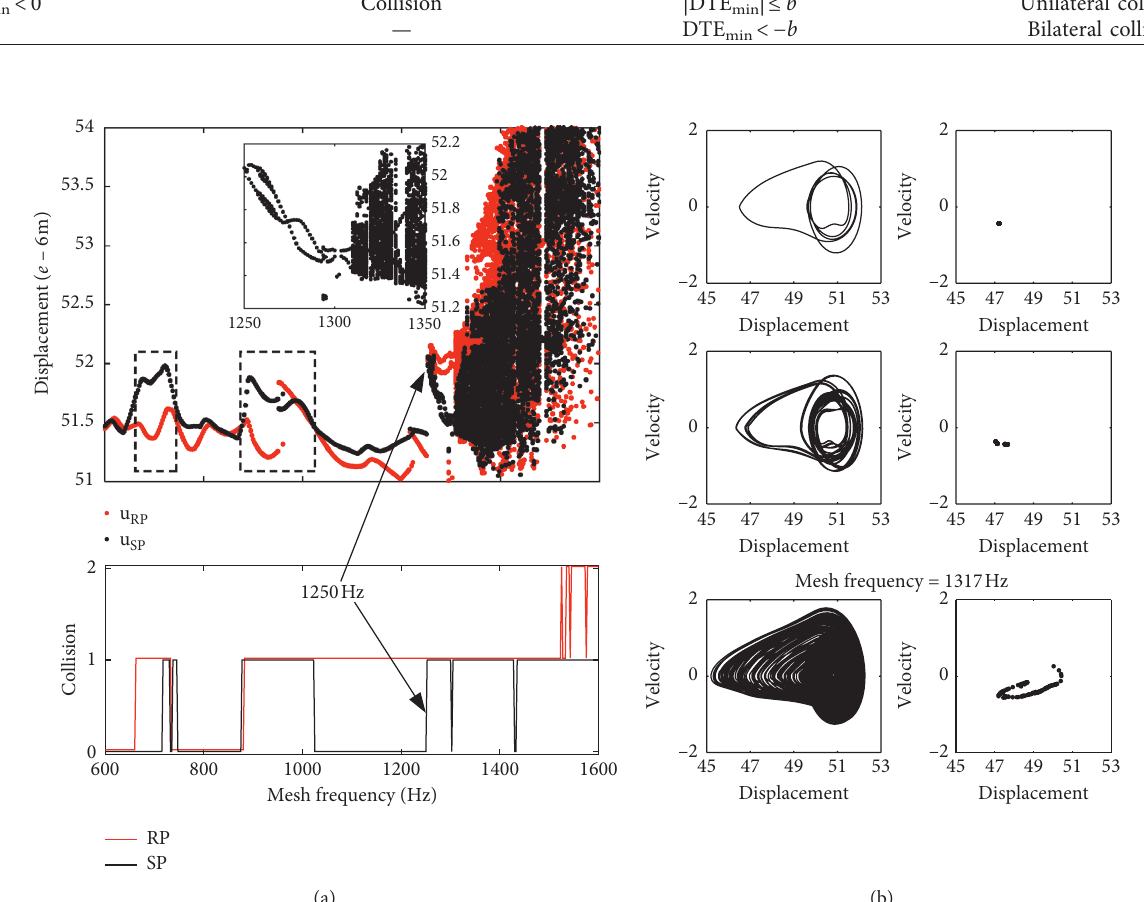
Figure 4: Nonlinear dynamics of the coupled system of the PGTand the SOWCs as rigid loads. (a) Bifurcation and collision diagrams of RP and SP. (b) Phase diagrams and Poincar´e maps of RP on key mesh